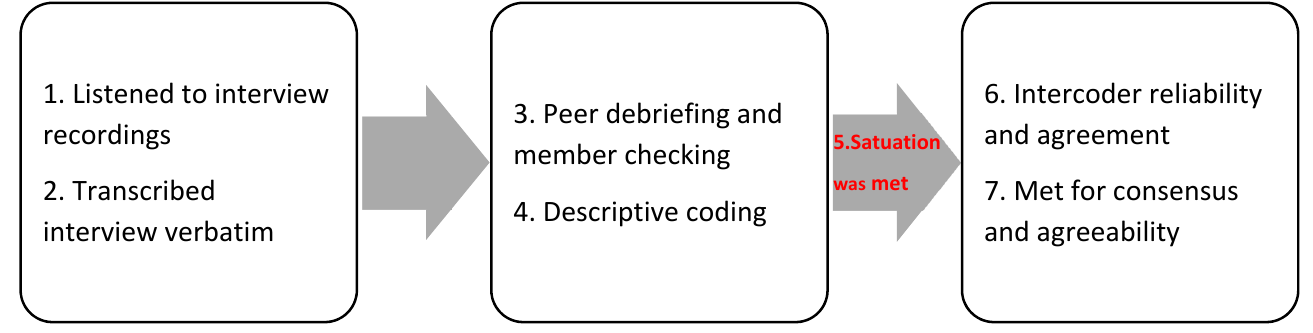
Figure 3. Data analysis.